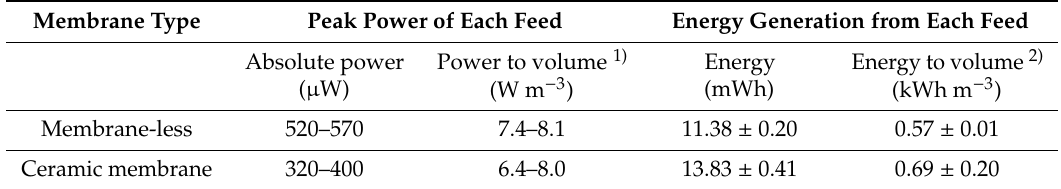
Table 2. Performance comparison between membrane-less and ceramic membrane microbial fuel cells (MFCs).